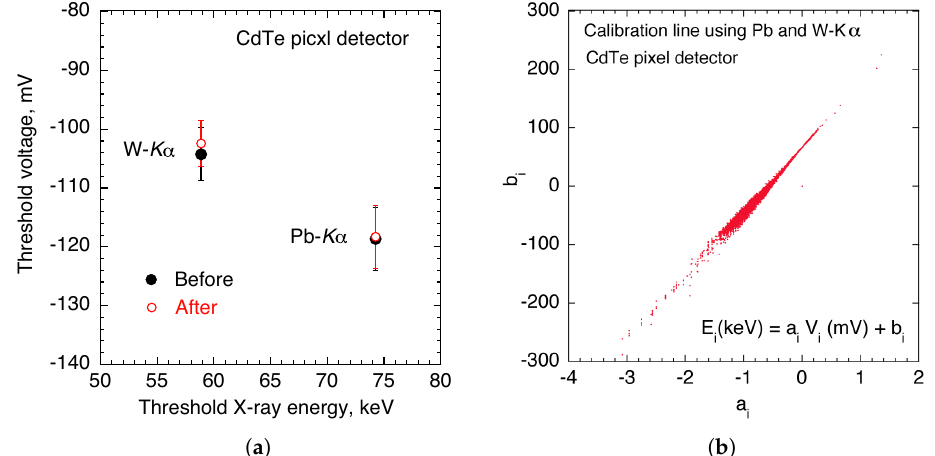
Figure 7. Results of the calibration of the CdTe pixel detector. ( a ) The means and standard deviations of threshold voltage for Pb and W- K α before and after the experiments; ( b ) distributions of coefficients a i and b i , which indicate the relationship between the threshold X-ray energy and threshold value for each pixel. The coefficients a i and b i were determined using the characteristic X-ray energies of Pb and W- K α